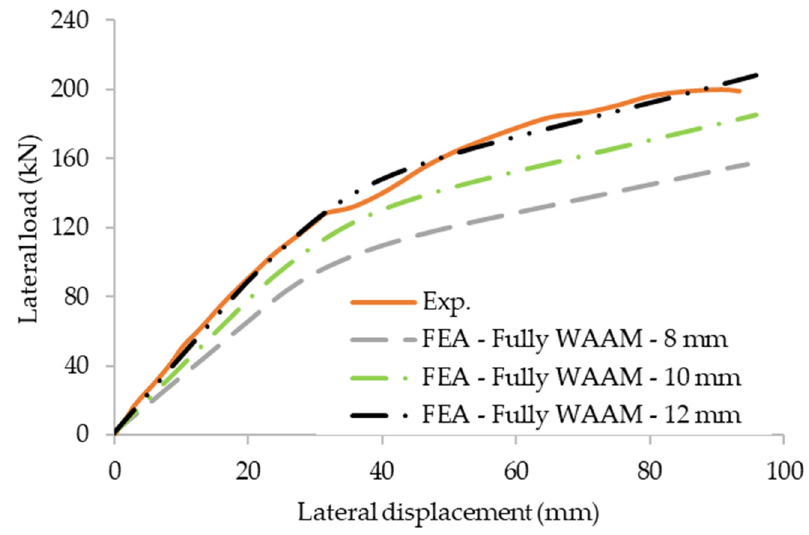
Figure 11. Lateral load-displacement behaviour of modular connection with increased